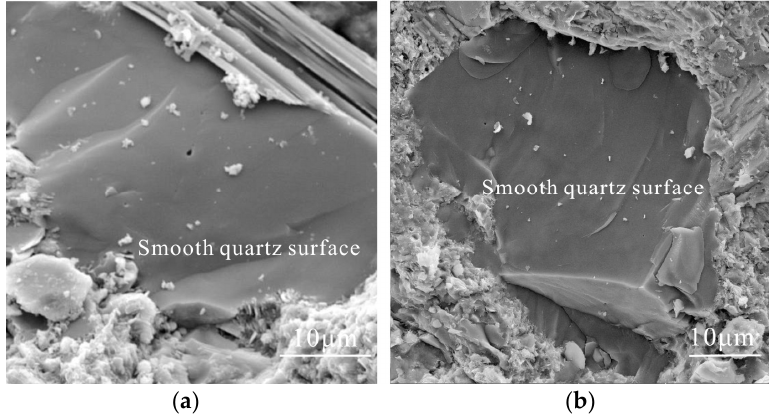
Figure 9. Scanning electron microscopy (SEM) images of Niutitang shale samples in the study area: ( a ) quartz contained fewer pores and has smooth surfaces, sample 4, and ( b ) quartz has smooth surfaces and no pores can be observed, sample 4.